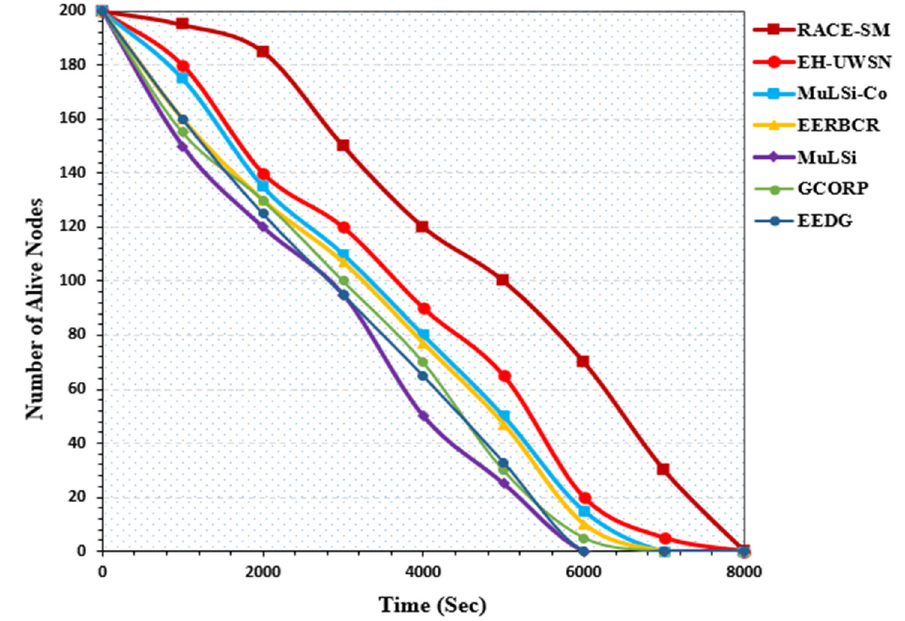
Figure 5. The Number of Alive Nodes.